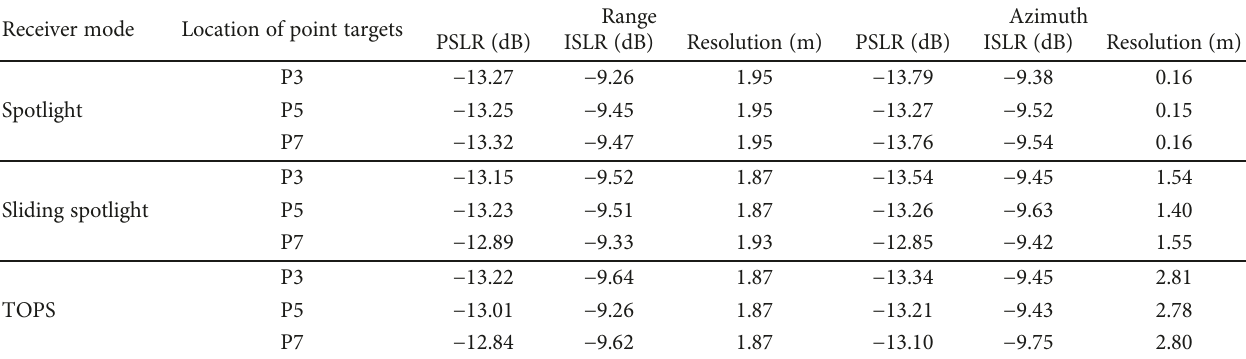
Table 3: Imaging qualities of the multipoint targets (P1, P5, and